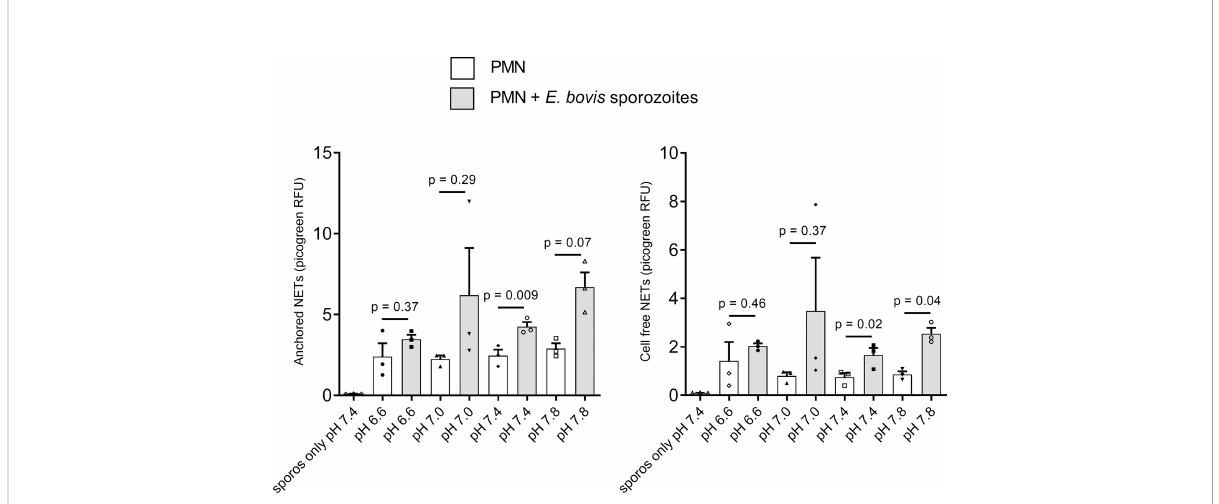
FIGURE 6 Effects of extracellular pH on E. bovis sporozoite-induced NETosis. Bovine PMN (n = 3) were suspended in RPMI 1640 media adjusted to different pH (6.6, 7.0, 7.4, and 7.8) levels and then exposed to E. bovis sporozoites. After 2 h of incubation, samples were centrifuged at 300 × g for 5 min. The supernatants were collected for cell-free NET measurement, and the pellets were used for anchored NET estimation. Extracellular DNA was detected and quanti fi ed by picogreen-derived fl uorescence intensities using an automated multi-plate reader. Values are presented as mean ± SEM in the graphs. p values were calculated by a paired two-tailed t-test analysis, comparing the PMN alone vs. the E. bovis -confronted PMN at each pH